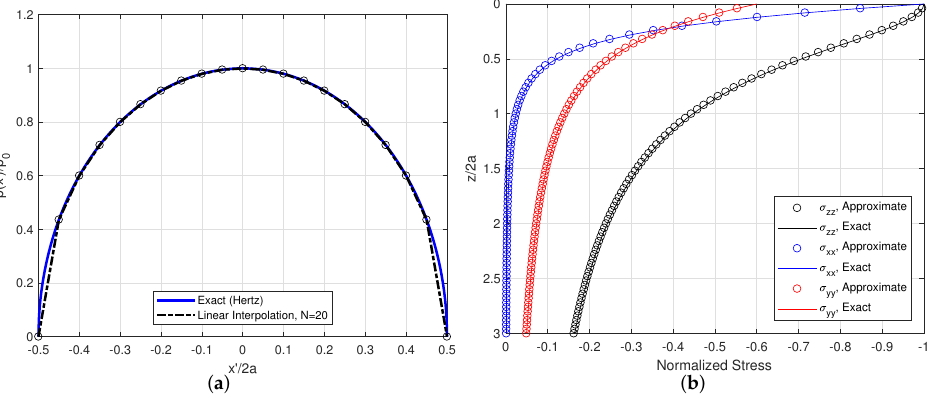
Figure 4. ( a ) The plane strain Hertz contact pressure field given by Equation (26), along with a linear interpolation consisting of N = 20 discretized subregions. ( b ) Comparison of the exact internal stress fields given in [29] with those approximated using the superposition of 20 potentials corresponding to the linear interpolants. The out-of-plane stress σ yy is calculated for a Poisson’s ratio ν = 0.3. The global error bound given by Equation (25) can not be calculated due to the fact that the slope of the tangent line of Equation (26) is infinite at the edge of the contact area; however, the stress fields still show strong convergence to the exact analytical